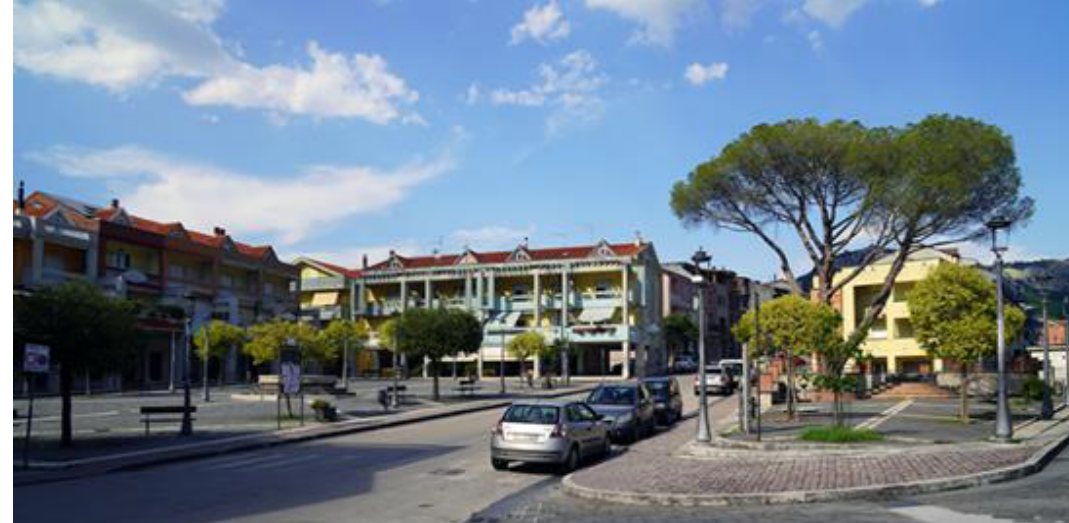
Figure 22. Laviano: Piazza della Repubblica (photos by [35,36]).